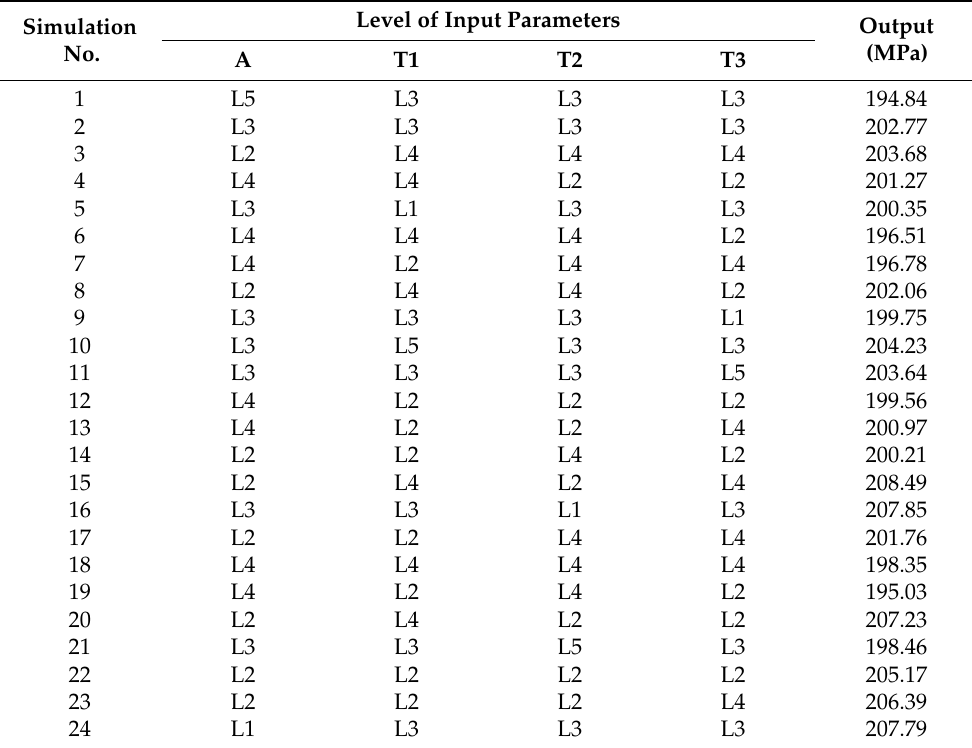
Table 4. Finite element results for the different settings of wall-thickness parameters and fiber angle based on the